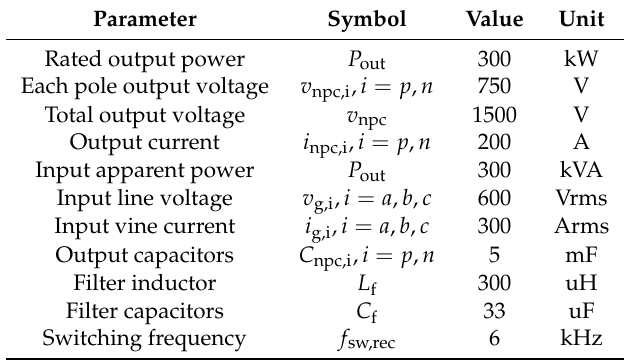
Figure 14. Prototype 3-level NPC AC/DC converter system for LVDC distribution: ( a ) forward; ( b ) backward. Table 1. Design specifications of the 3-level neutral-point clamped (NPC) AC/DC converter parameters.